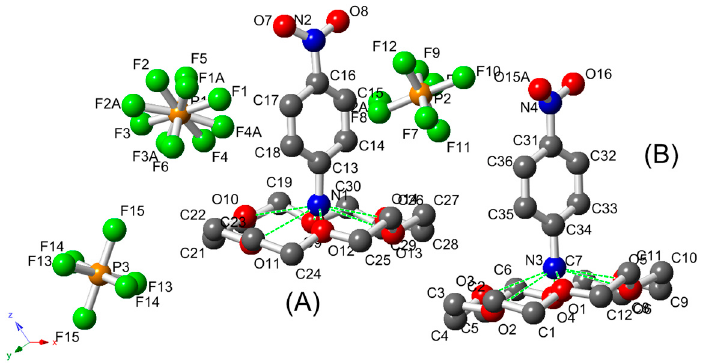
Figure Figure 2. ( A , B ) Asymmetric unit of compound 1 .